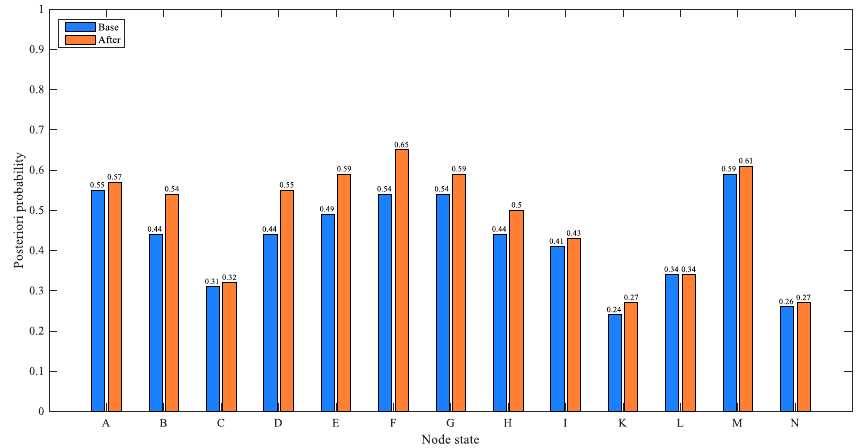
Figure6. Comparisonoftheprobabilityofothernodesbeforeandafterthestateof“externalsupervision” Figure 6. Comparison of the probability of other nodes before and after the state of “external changes to supervision” changes to inadequate.